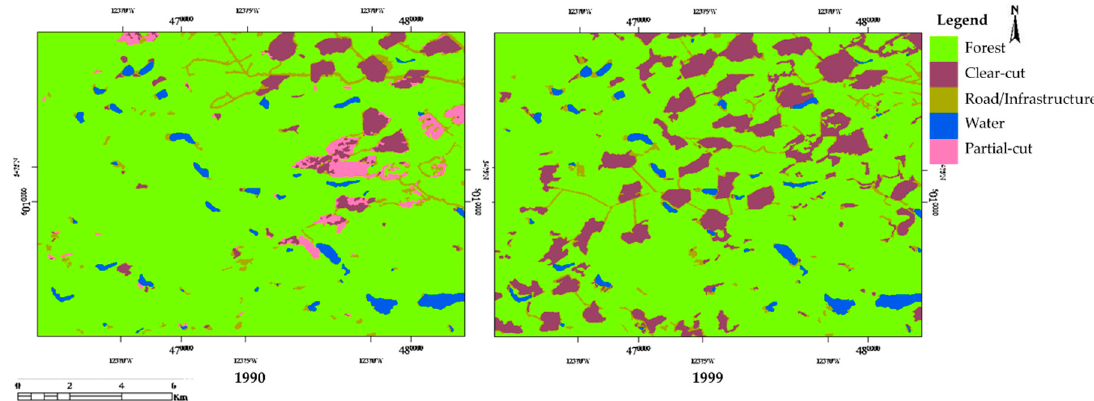
Figure 4. The resultant images obtained by the Random Forest (RF) classifier using the Experiment I data set.